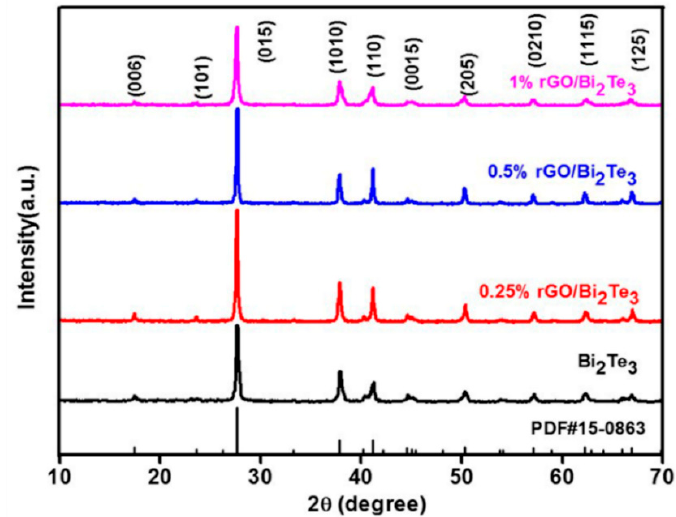
Figure 2. XRD patterns of the rGO/Bi 2 Te 3 nanocomposite powders with different contents of rGO from 0 to 1 wt%.